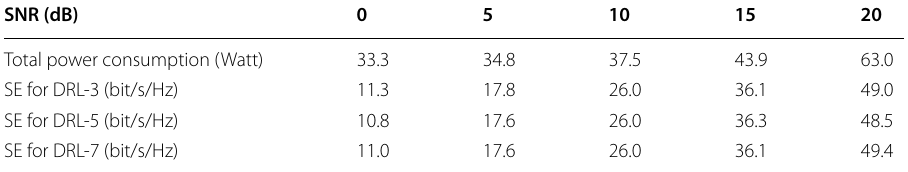
Table 7 The total power consumption and the average SE for DRL models at different SNRs SNR (dB)